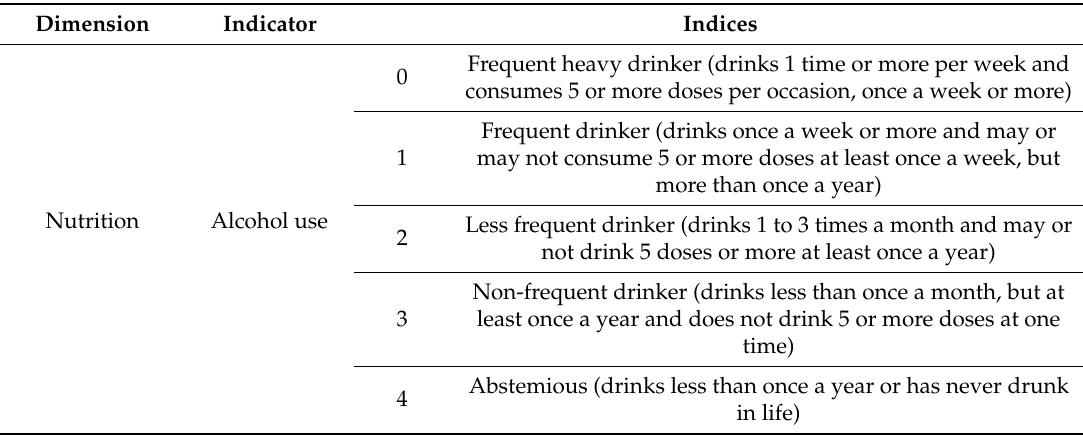
Table 3. Example of IWHAI nutrition verification